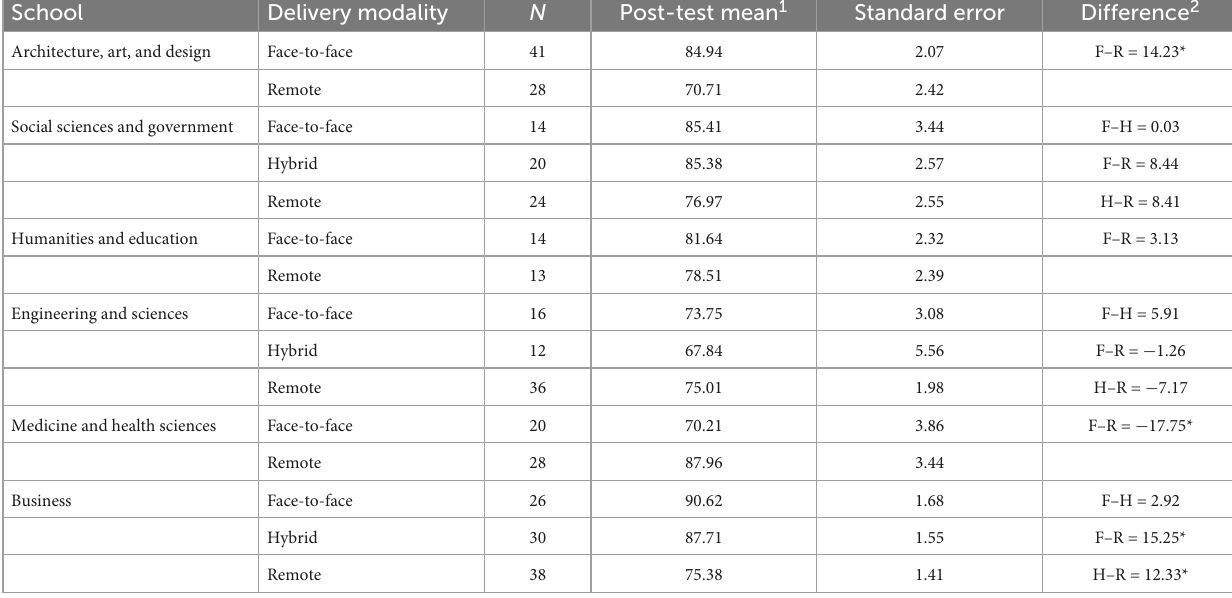
TABLE 1 Students’ learning level in the face-to-face, hybrid, and remote